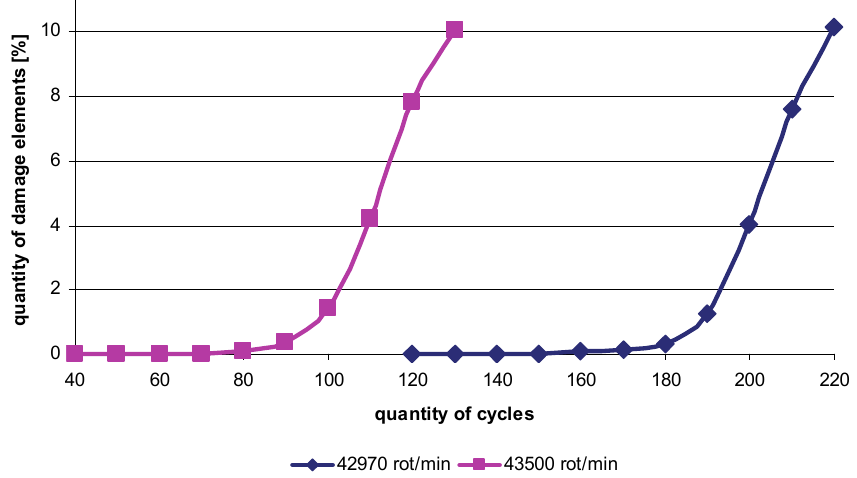
Figure 11: Quantity of the damaged finite elements versus the number of thermal cycles (Temperature